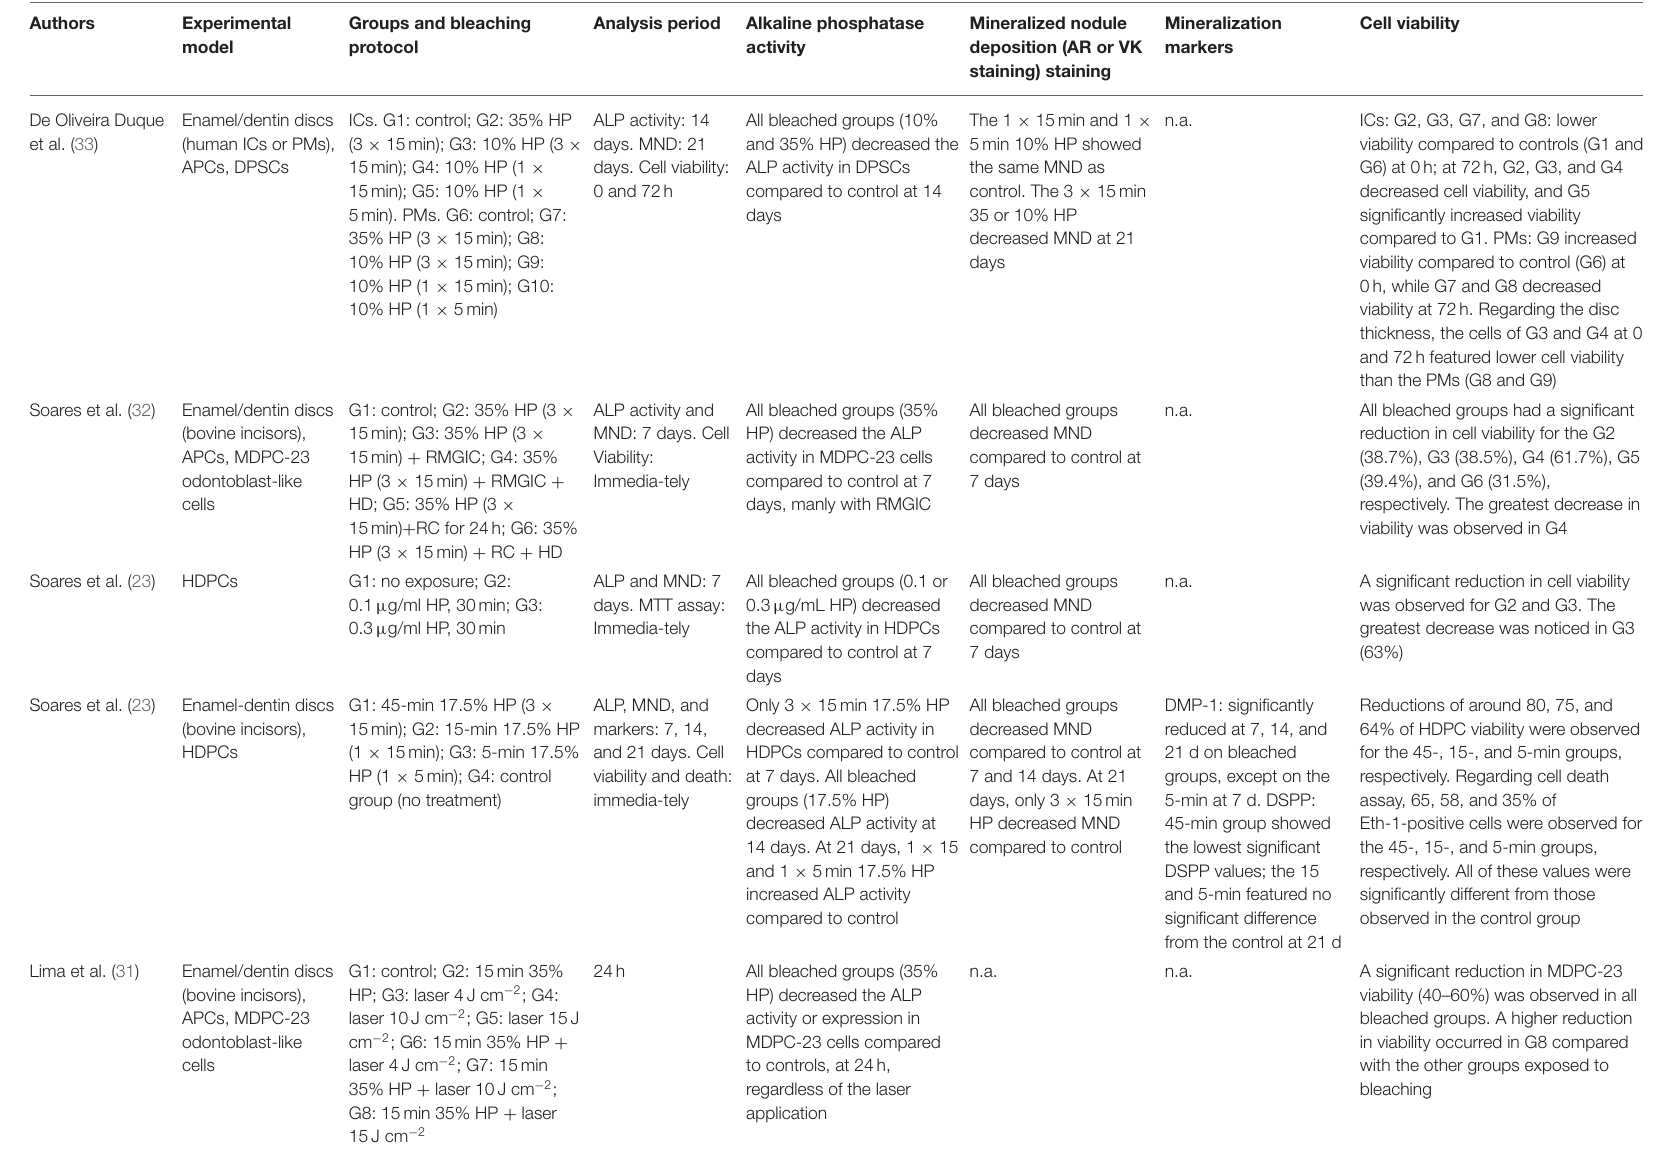
TABLE 1 | Characteristics of the studies included in the review and synthesis of